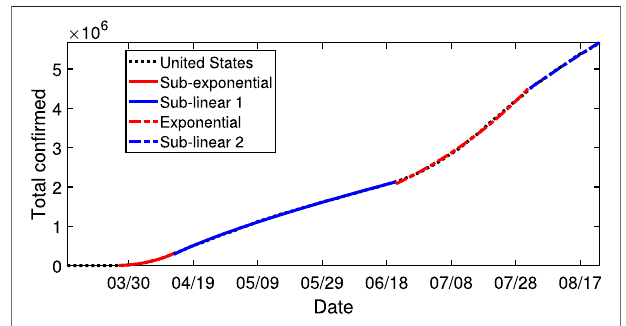
FIGURE 5 | The fi tting results of United States of America. The black dashed curves represent the real data. The red curve and red dashed curve represent the sub-exponential and exponential growth of the total con fi rmed cases changing with time. The blue curve and blue dashed curve represent the sub-linear growth with time. The parameters and dates in consideration for different cases are listed in Table 1